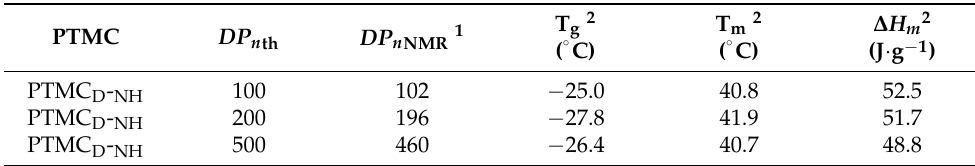
Table 3. Investigation of high molar mass PTMC.